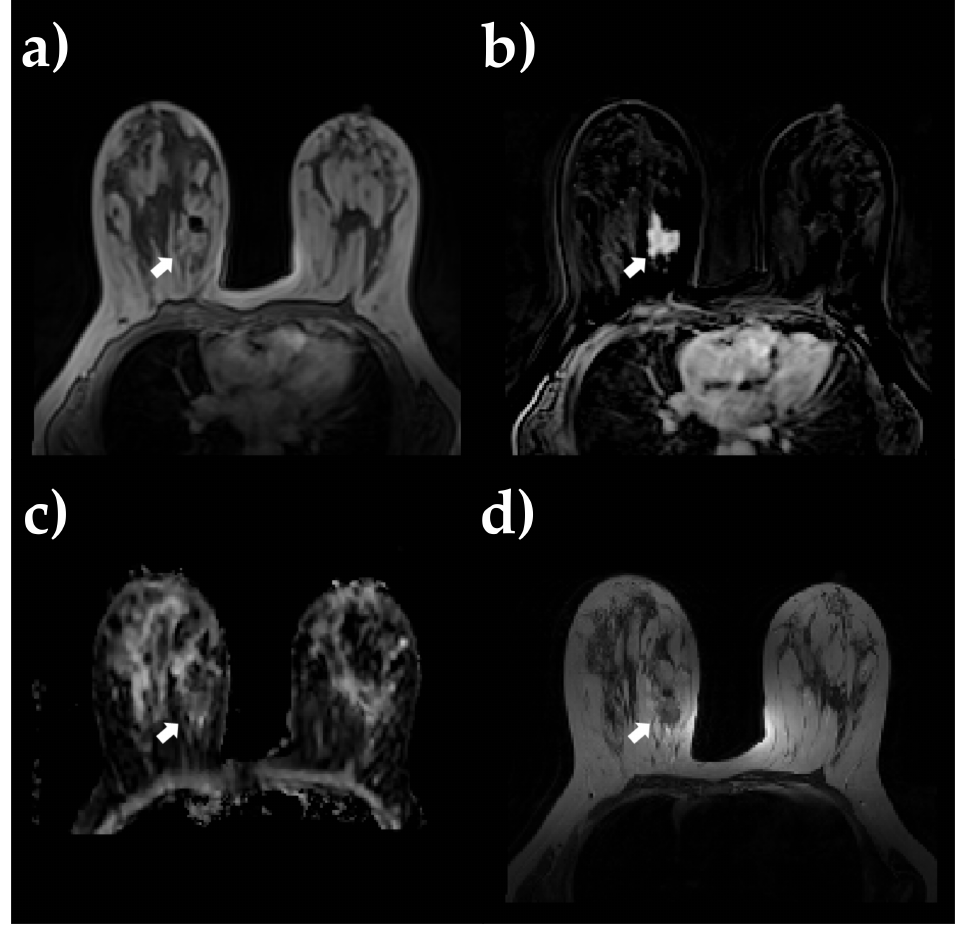
Figure 2. Example of primary BC lesion shown on a pretreatment breast MRI: ( a ) post-contrast T1 images, ( b ) DCE-MRI subtraction images with the highest mean signal intensity within the ROI, ( c ) ADC map, and ( d ) T2